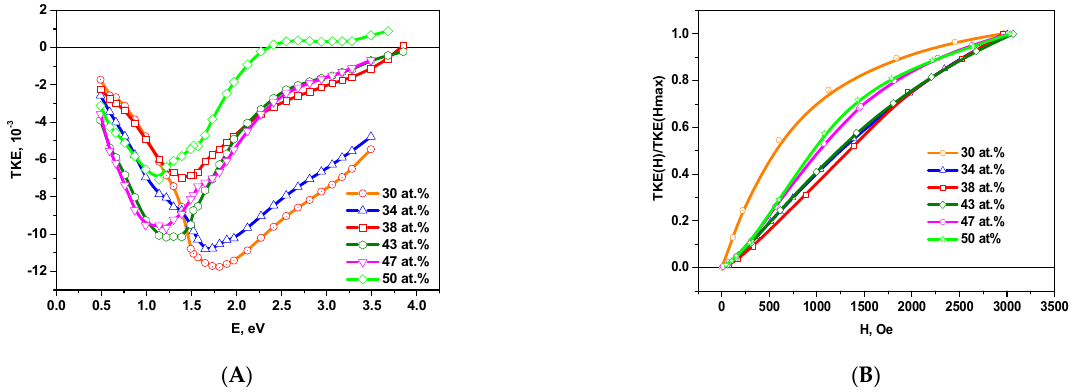
Figure 6. Spectral TKE(E) ( A ) and normalized field TKE(H)/TKE(Hmax) ( B ) dependences for composites on the glass substrates with metal concentrations x ≥ 30 at.%.